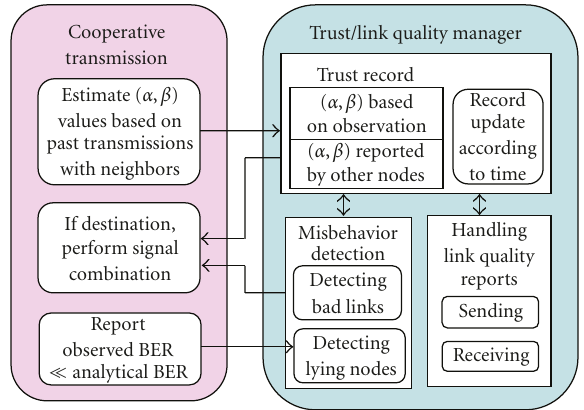
Figure 3: Overview of trust-assisted cooperative